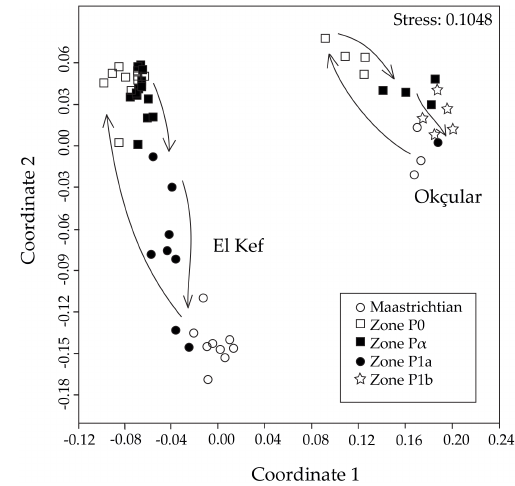
Figure 7. Q-mode non-metric multidimensional scaling (on all sam- ples in the >125µm size fraction benthic foraminiferal datasets of Okçular (this study) and El Kef (Speijer and van der Zwaan, 1996). After an abrupt transition from latest Maastrichtian pre-impact as- semblages to disaster assemblages in Zone P0 and recovery assem- blages in Zone P α , a gradual transition towards a new equilibrium post-recovery assemblage can be observed in subzones P1a and